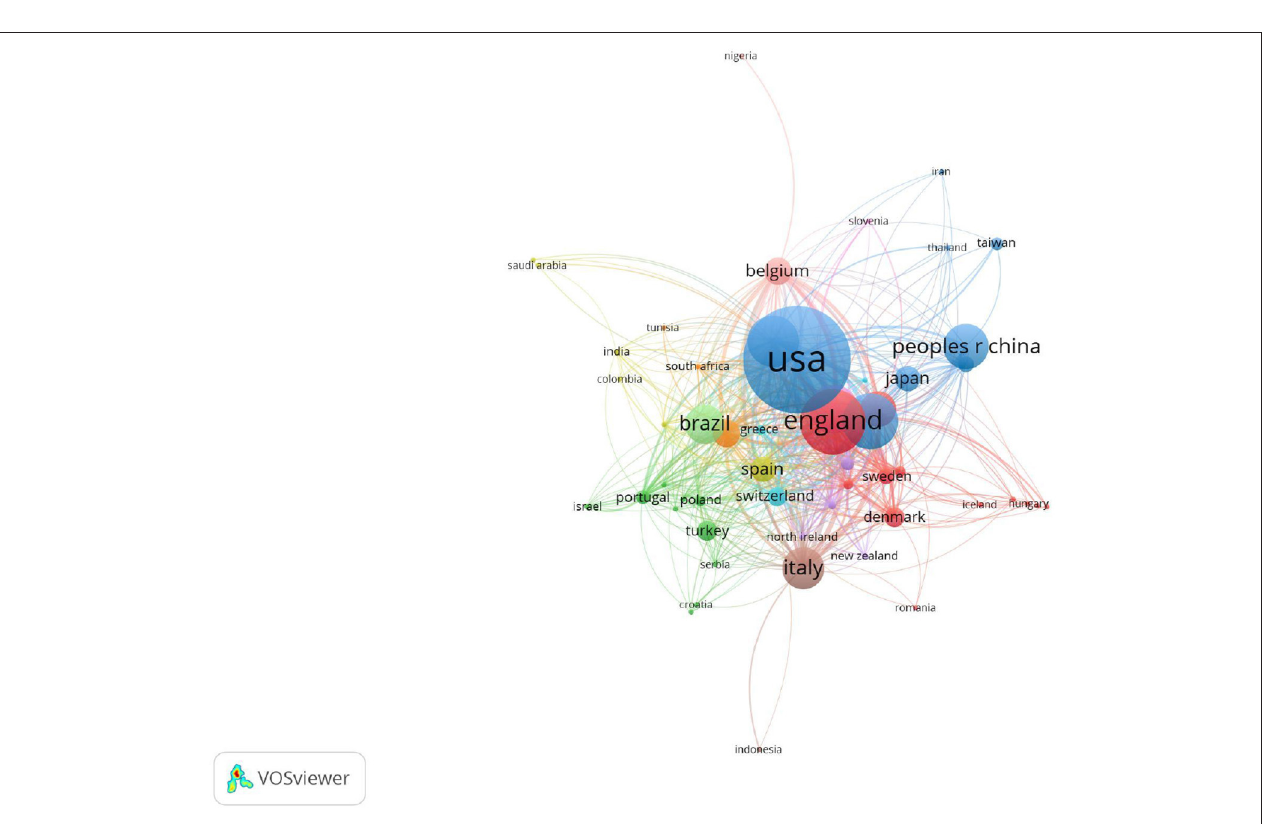
FIGURE 4 | The co-authorship map of the distribution of country/region for the research on pulmonary